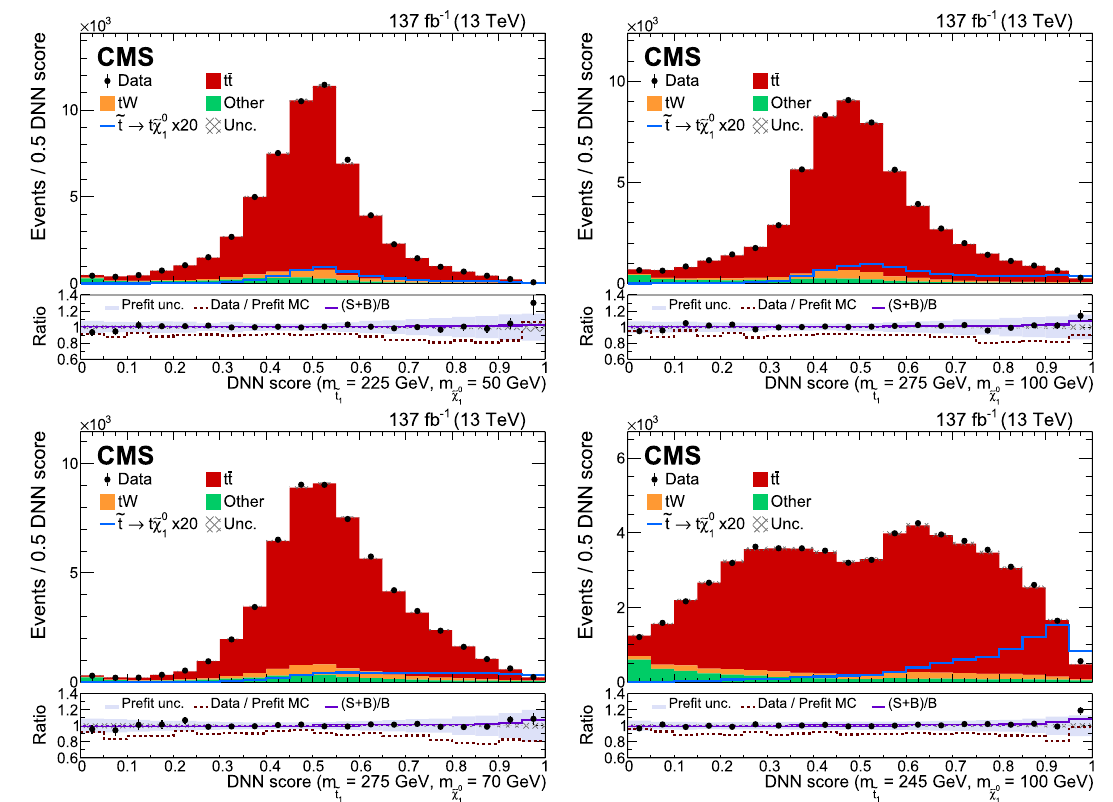
Fig. 6 Post-fit DNN score distributions in the signal region for differ- ent mass hypotheses of, from upper left to lower right, ( m (cid:2) t1 , m (225, 50); (275, 100); (275, 70); and (245, 100)GeV. The superim- posed signal prediction is scaled by the post-fit signal strength and, in the upper panels, it is also multiplied by a factor 20 for better visibility. The post-fit uncertainty band (crosses) includes statistical, background normalization, and all systematic uncertainties described in Sect. 6.4. Events from ttW, ttZ, DY, nonprompt leptons, and dibo-